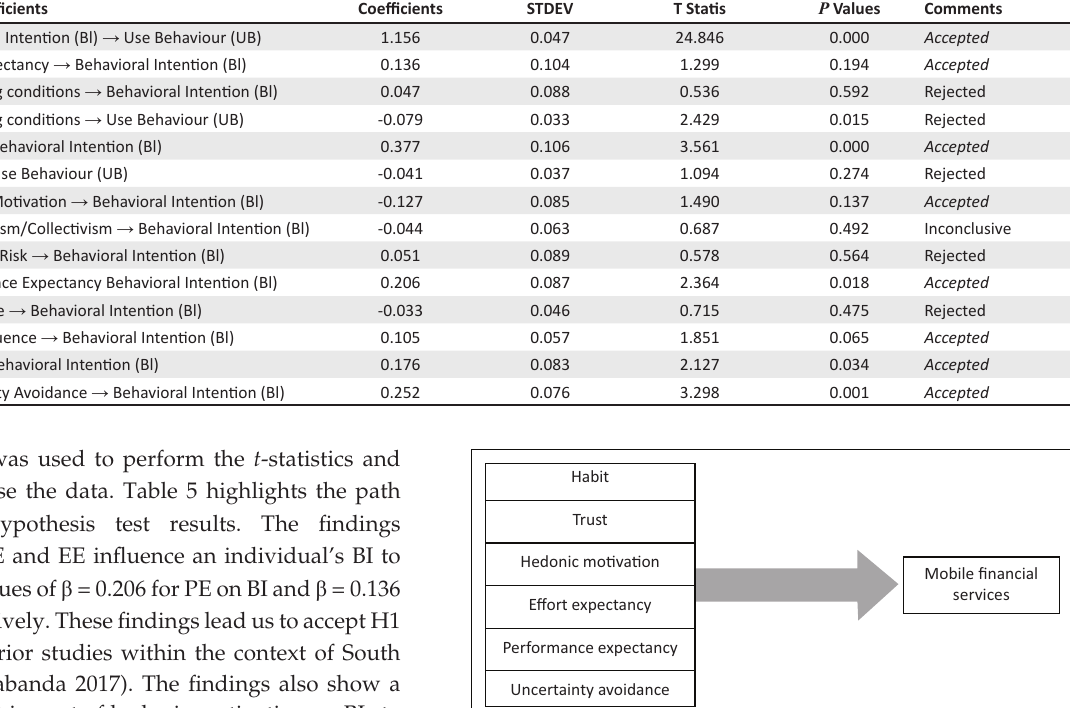
TABLE 5: Hypothesis testing. Hypothesis